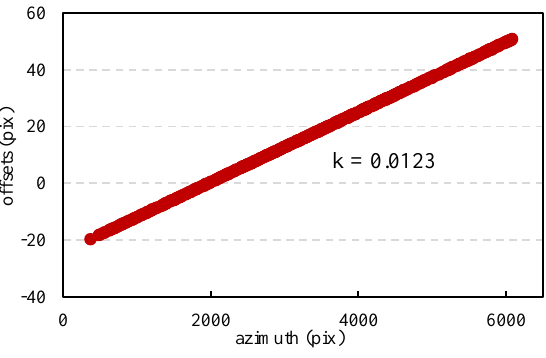
Figure 5. Variation of the offsets along the azimuth.